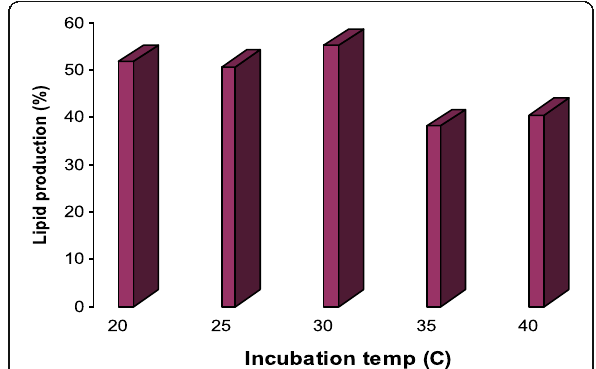
Fig. 4 Effect of incubation temperatures on F. oxysporum NRC